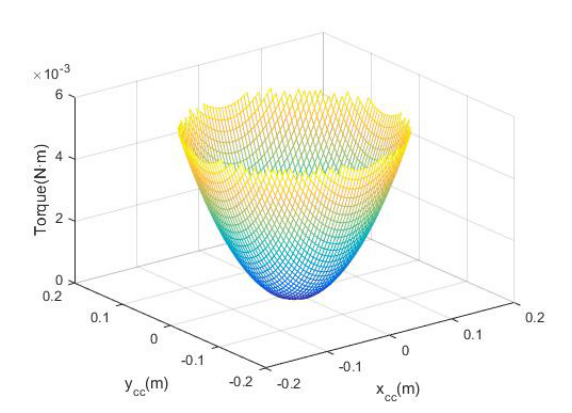
Figure 8. Joint torque affected by x cc and y cc .